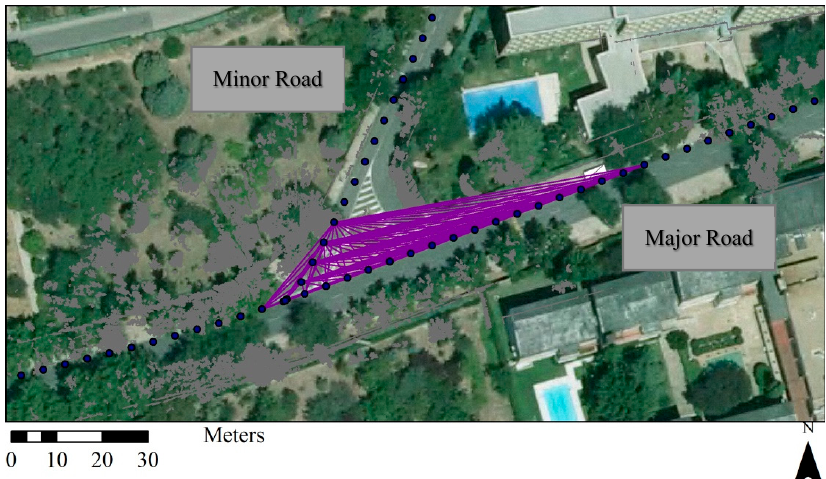
Figure 8. Orthogonal view of the intersection under study, the multipatch features are colored in gray and the top of the bus stop shelter is colored in white.